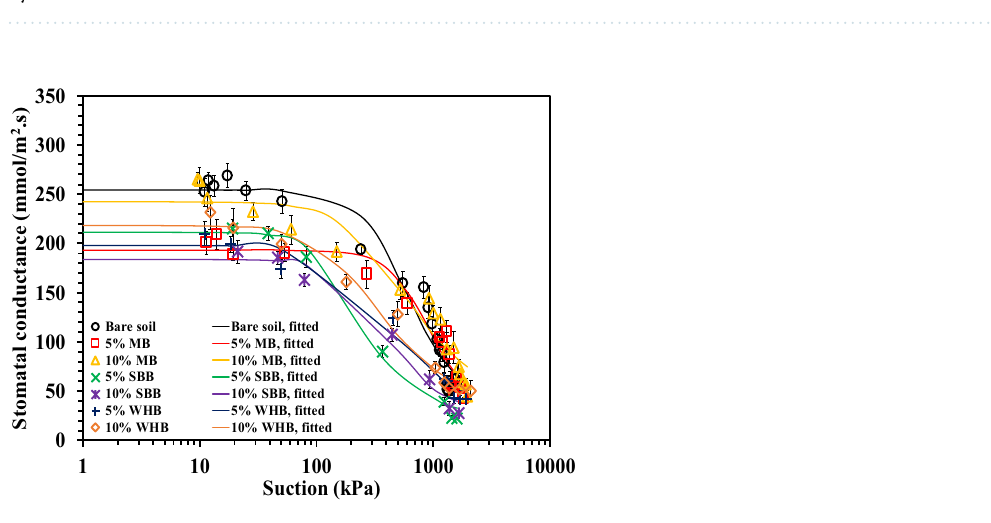
is expected, however leaf porometer evaluates the SC based on the measured temperature and relative humidity, and a slight change in these parameter could yield a large SC value. Figure 10a,b highlights the variation of maximum (F v /F m ) and effective (PY(II)) photosynthetic yield (PY) with suction in different BAS. The PY versus suction plot followed the similar pattern of SC versus suction. The peak value of (F v /F m ) and PY(II) were observed to be above 0.7 on a measuring scale of 0–0.84 which indicates the healthy condition of the leaves or the vegetation. The peak PY value of around 0.7 was also reported for grass